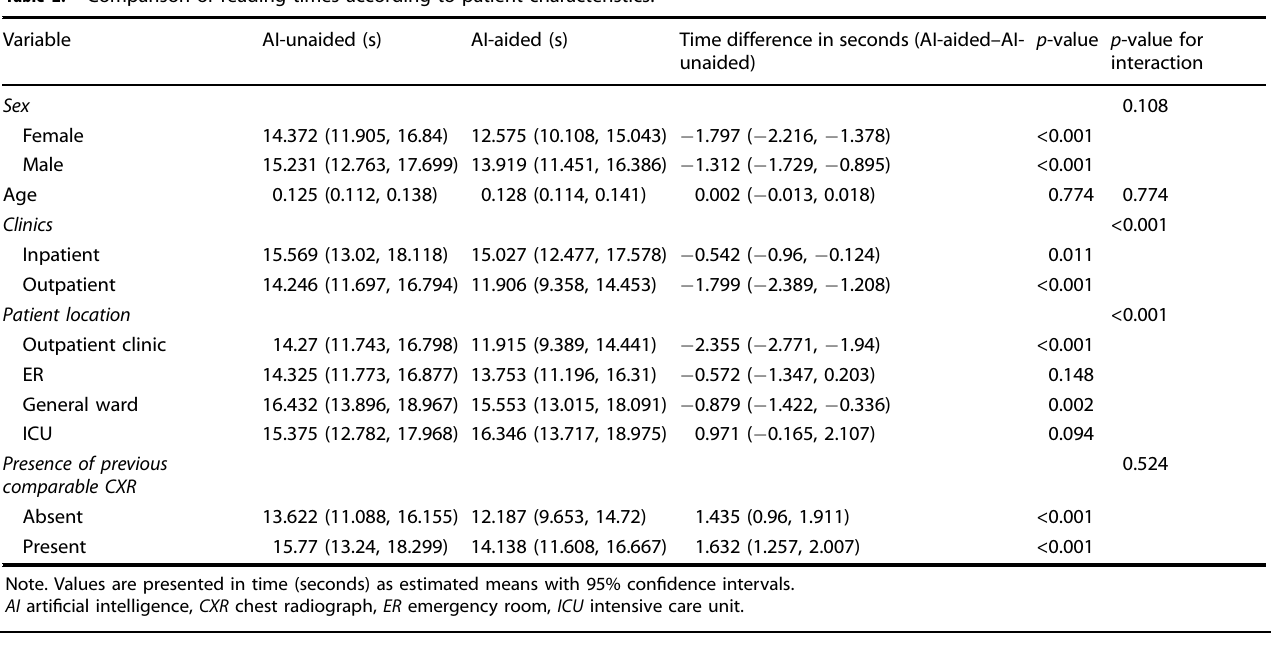
Table 2. Comparison of reading times according to patient characteristics.